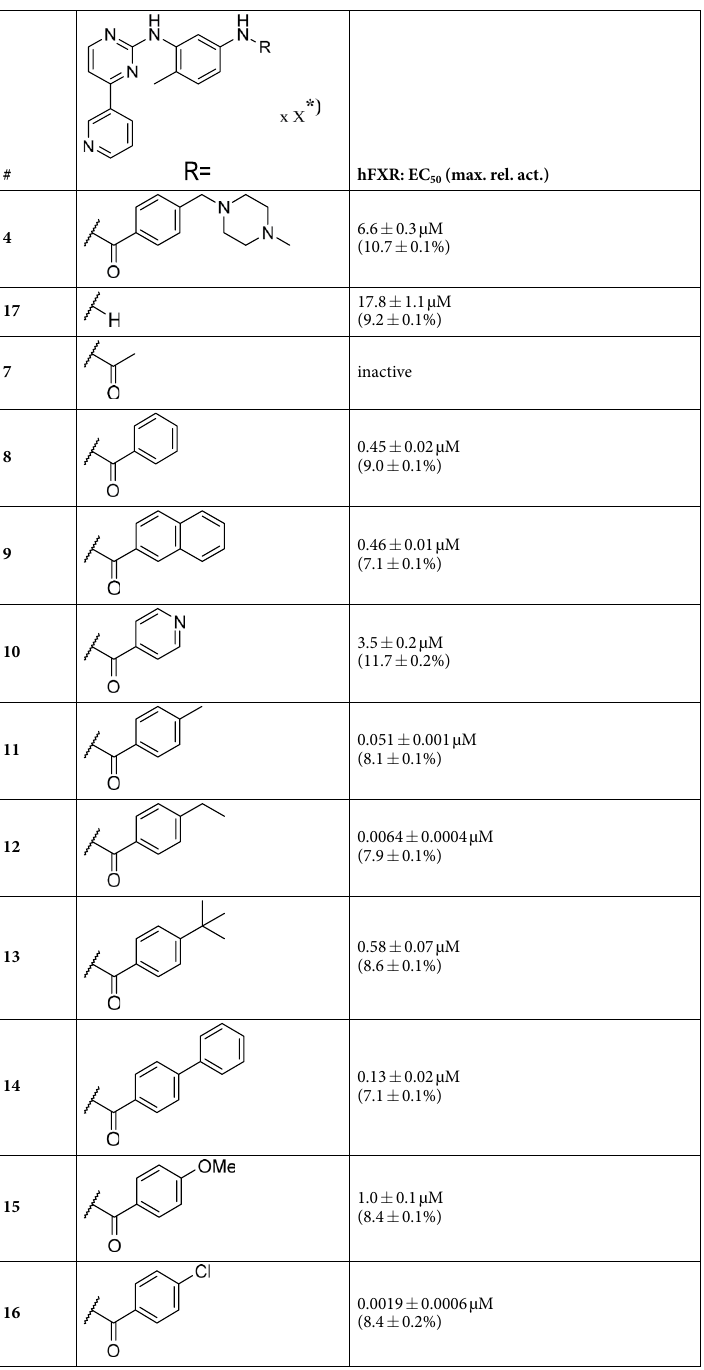
Table 1. Structure-activity relationship of 4 and derivatives 7 – 17 on FXR in a full-length reporter gene assay. (Data represents mean ± SEM; n ≥ 3; p < 0.05 for every concentration ≥ EC 50 value.) * Salt compositions of 7 – 17 differed and are accurately described in the